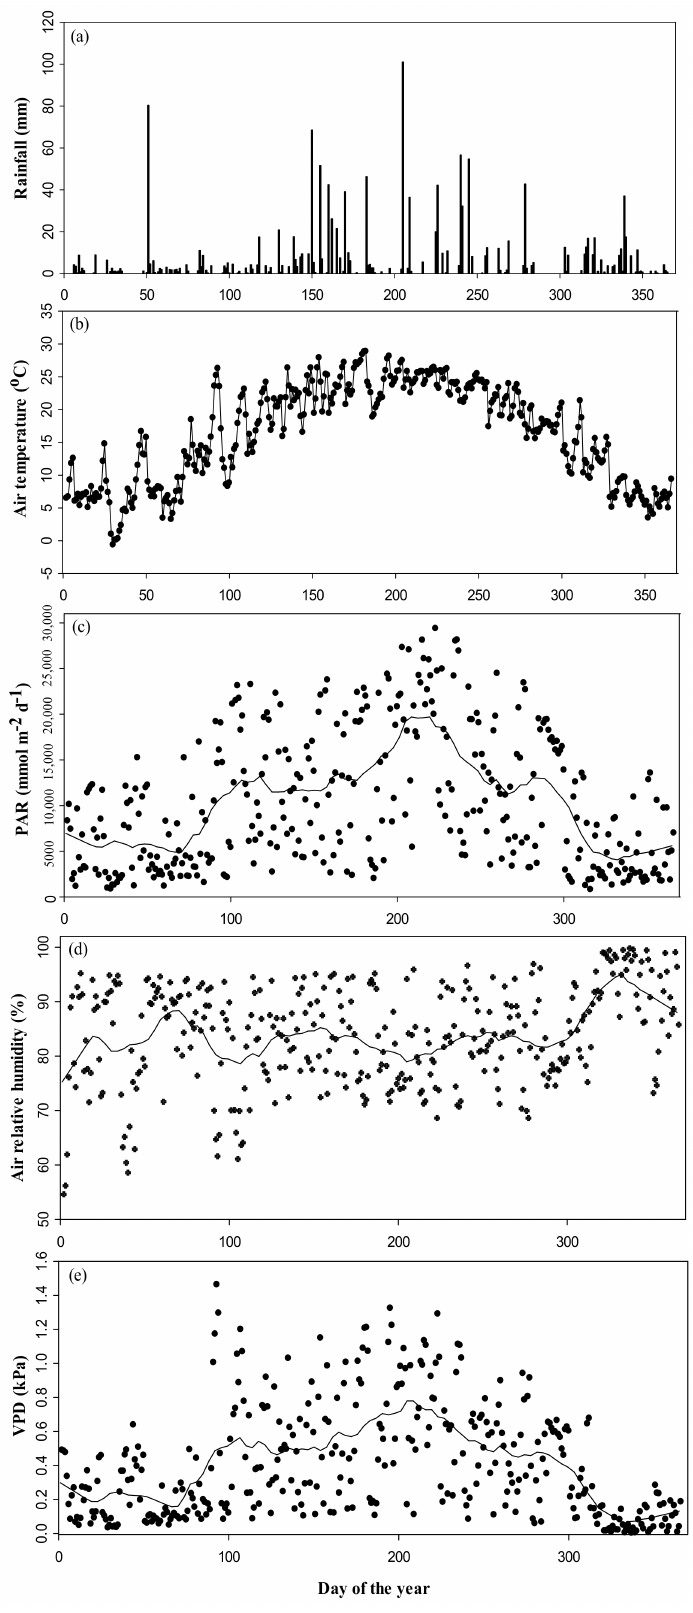
Figure 2. Variation of daily environmental variables of the study plot in 2015. ( a ) rainfall (mm); ( b ) air temperature (T a ) ( ◦ C); ( c ) photosynthetically-active radiation (PAR) (mmol m − 2 day − 1 ); ( d ) air relative humidity (RH) (%); and ( e ) vapor pressure deficit (VPD)